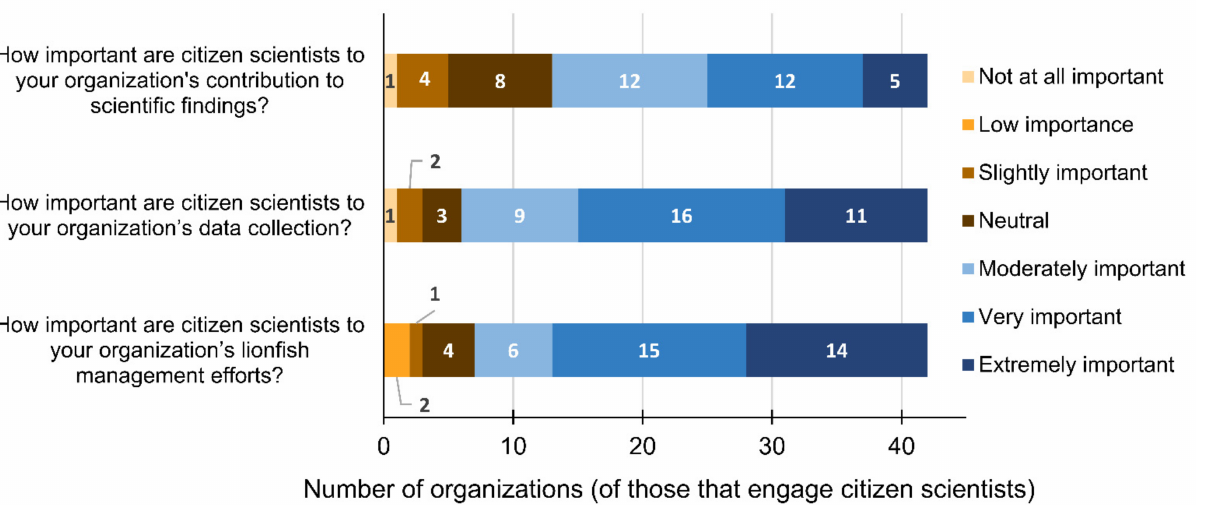
Figure 3. Importance of citizen scientists to research and management ( n = 42). Counts for each category of a Likert scale from “Not at all important” to “Extremely important”, in which organization representatives indicated how important citizen scientists are to contributing to scientific findings, data collection, and lionfish management